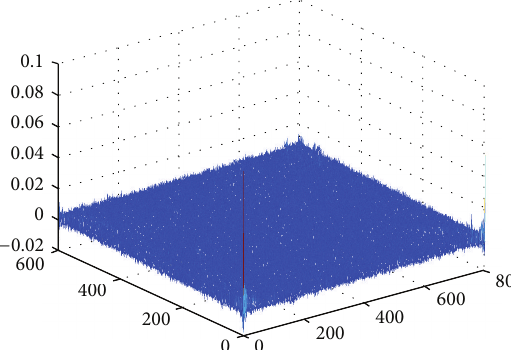
Figure 5: POC function for PolyU palmprint